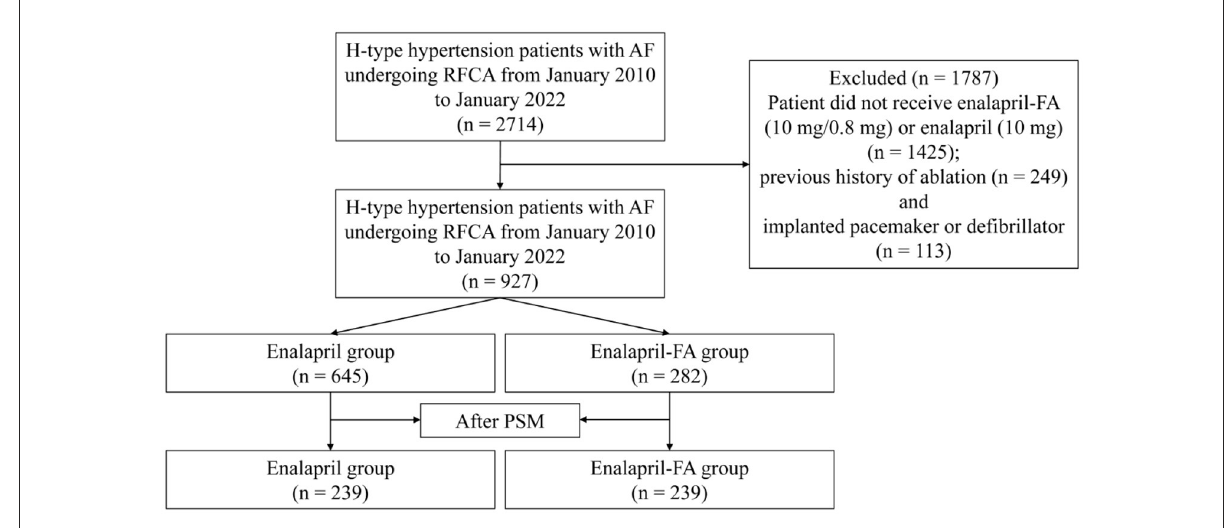
FIGURE1 Study cohort flow diagram. AF, atrial fibrillation; RFCA, radiofrequency catheter ablation; FA, folic acid; PSM, propensity score